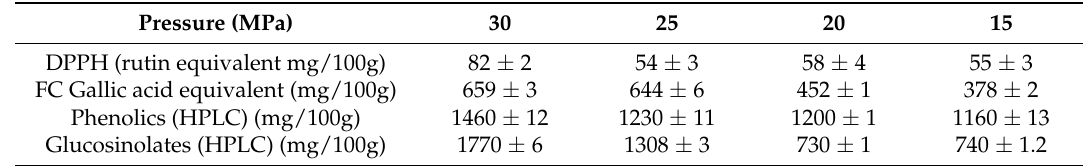
Table 8. Antioxidant activity and total secondary metabolite contents in Eruca sativa extract obtained by SCO 2 -water at different pressures and a constant temperature of 65 ◦